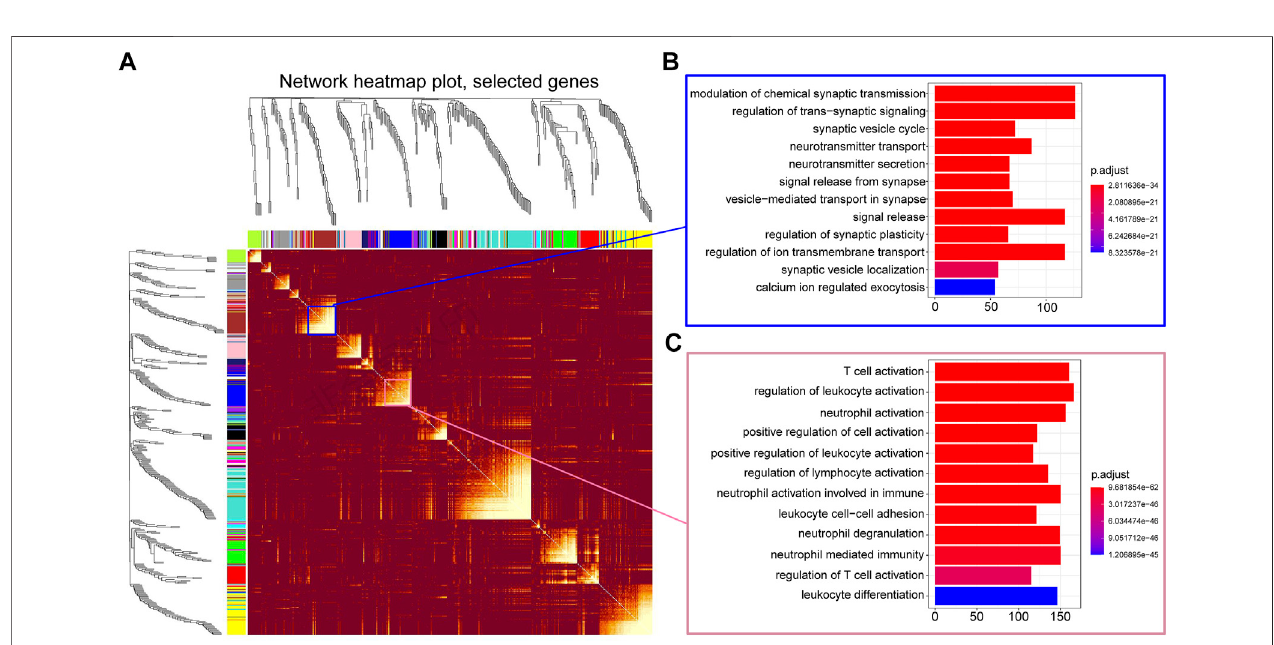
FIGURE5| Highlycorrelatedgeneclusterswereidenti fi edbyWGCNA. (A) Topologicaloverlappingheatmapof400genes. (B) GOenrichmentanalysisofmodule 5. (C) GO enrichment analysis of module 8.